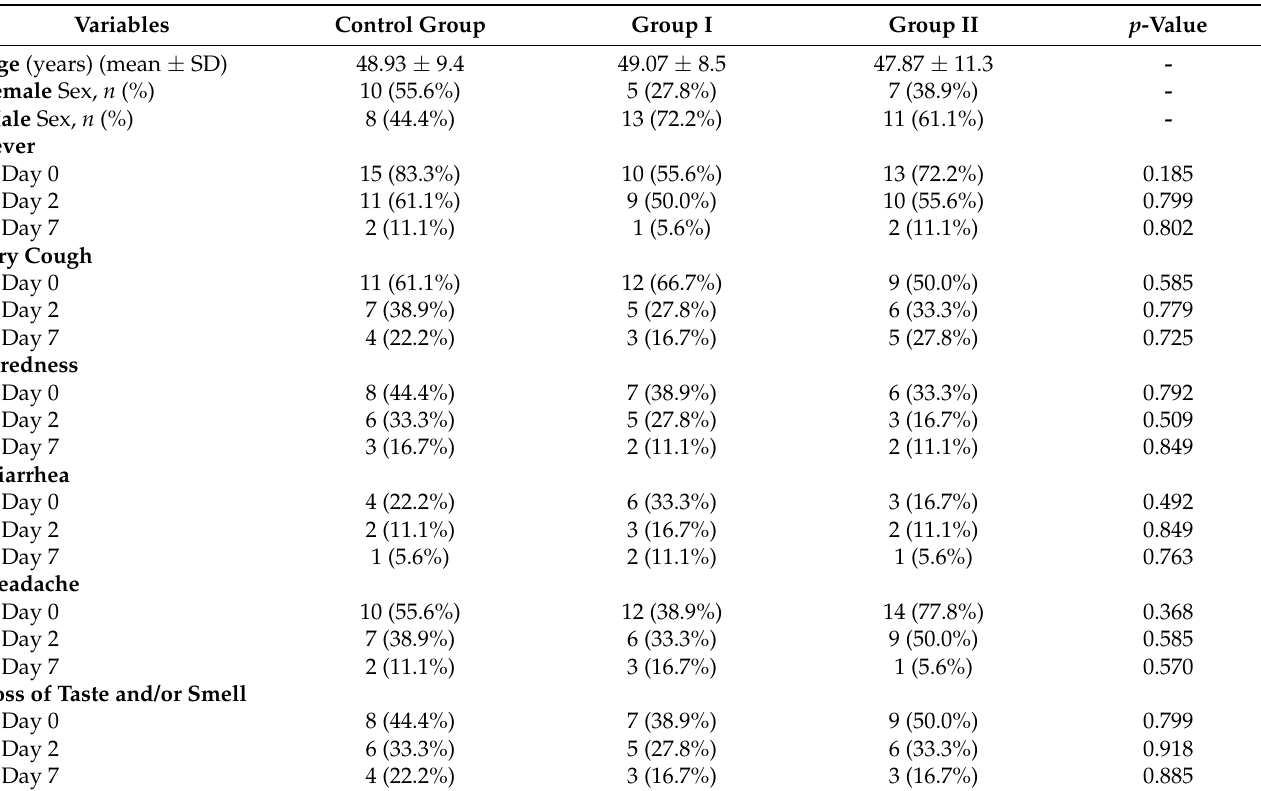
Table 1. Demographic and clinical characteristics of